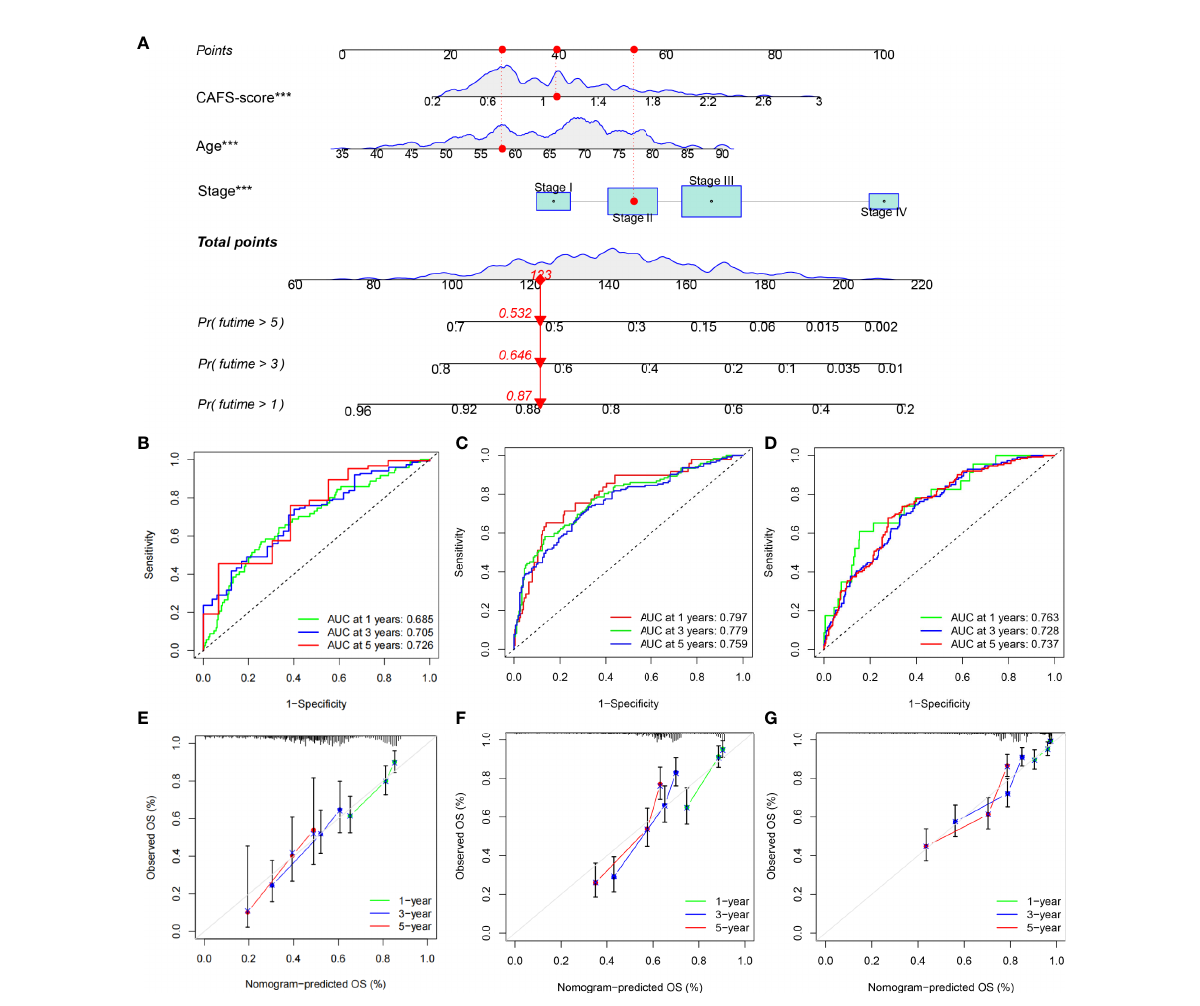
FIGURE 11 Construction and validation of a nomogram. (A) Nomogram for predicting the 1-, 3-, and 5-year OS of GC patients in TCGA cohort. (B-D) ROC curves for predicting the 1-, 3-, and 5-year ROC curves in TCGA, GSE62254, and GSE26253 cohorts. (E-G) Calibration curves of the nomogram for predicting of 1-, 3-, and 5-year OS in the TCGA, GSE62254, and GSE26253 cohorts.